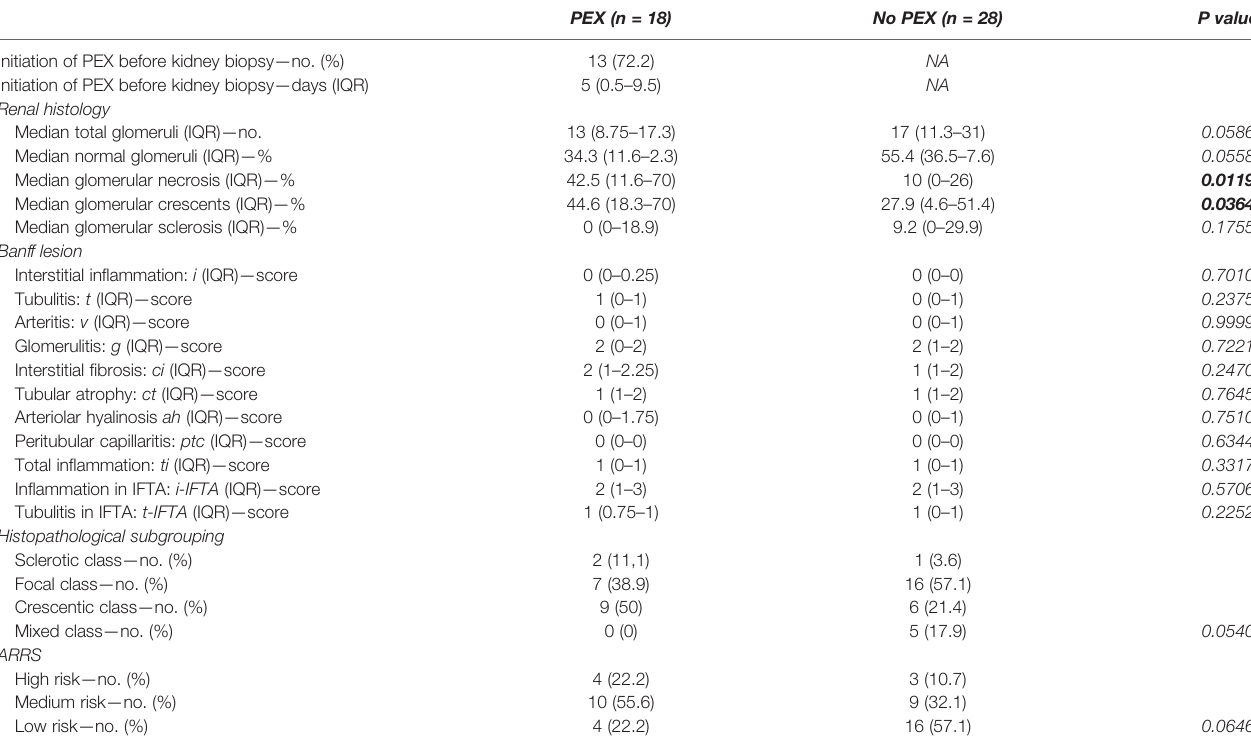
TABLE 2 | Renal histopathological fi ndings: PEX versus no PEX in severe AAV.